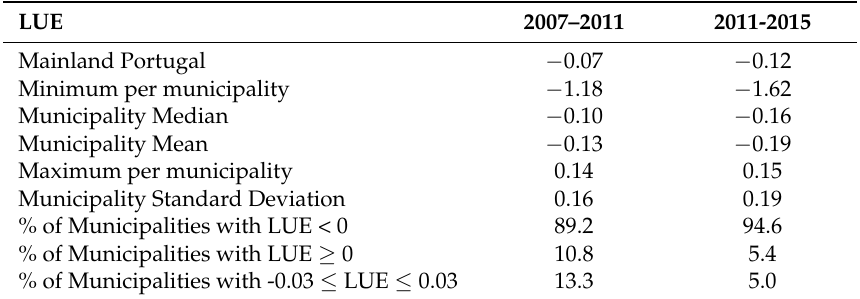
Table 5. Characterisation of the LUE estimates produced by COS for the periods 2007–2011 and 2011–2015.